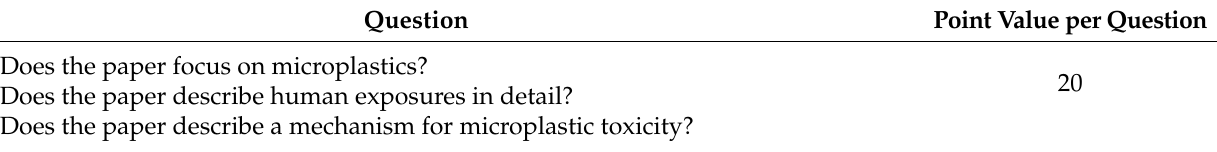
Table 1. Questions used to screen the abstracts for inclusion in the scoping review and their associated